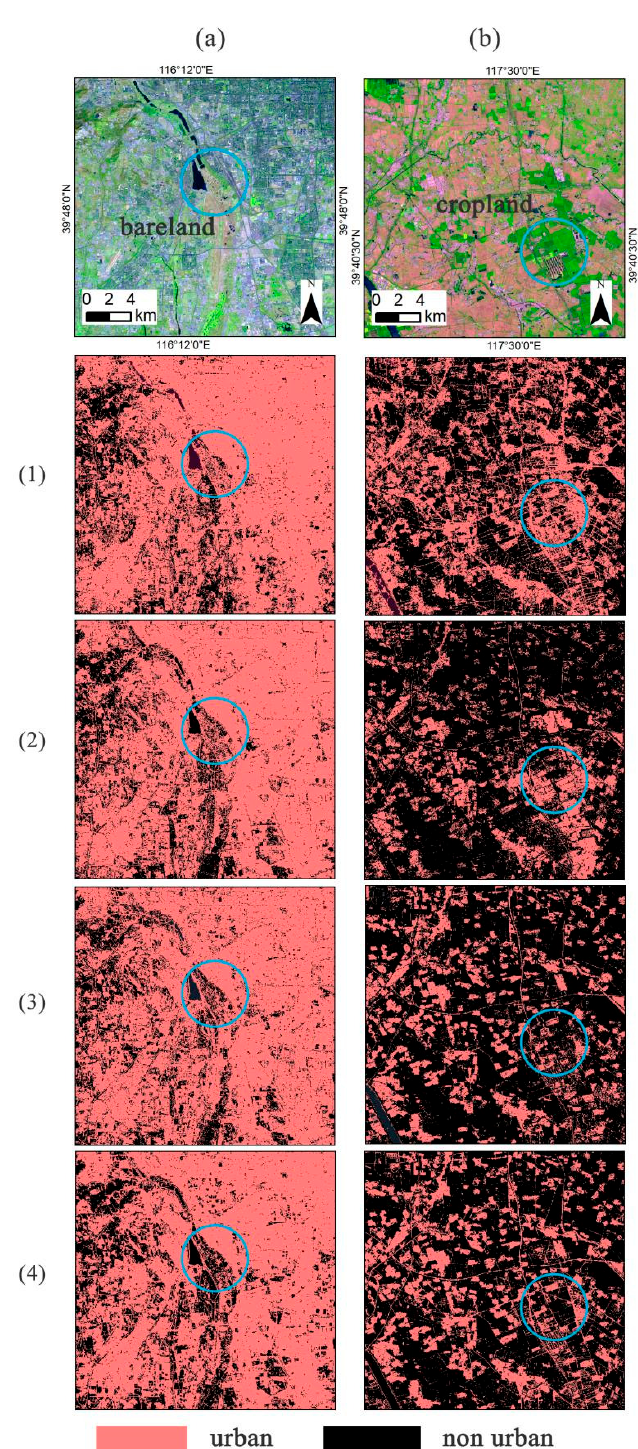
Figure 8. Performance comparison in the representative cities. (The first row represents the Land- sat 8 data (R: Band 6; G: Band 5; B: Band 4); 1, 2, 3, and 4 represent the schemes in Table 3.)